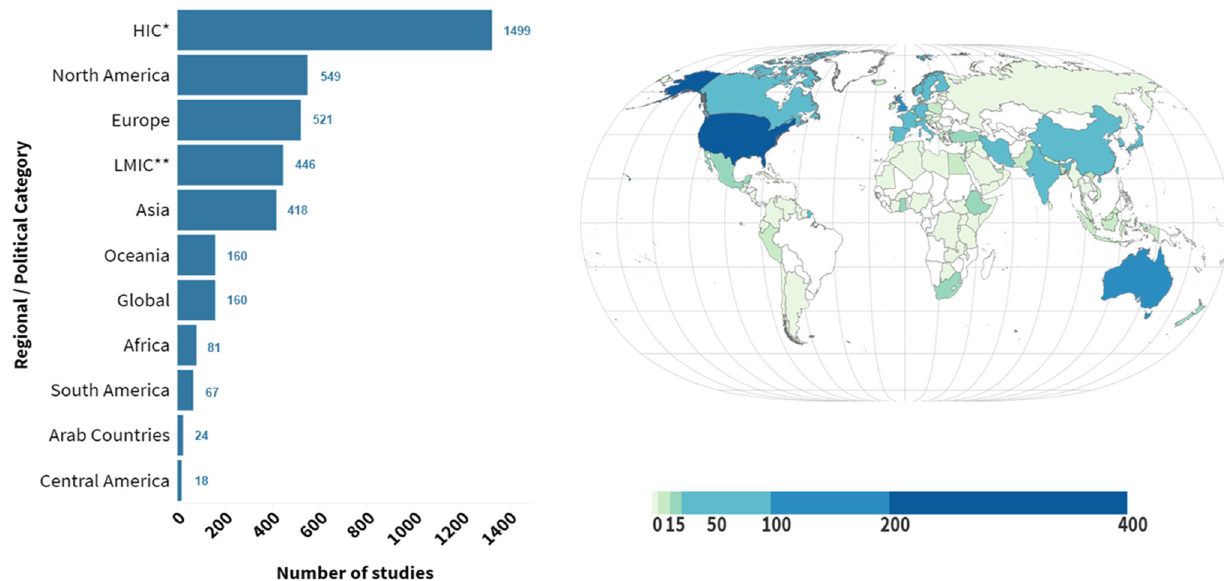
Fig. 5| Choropleth Map andbarplotofstudiesby geographic distribution. The barplotonthe leftshowsthenumber of studiesbyregion and politicalcategory,and the map on the right shows number of studies by